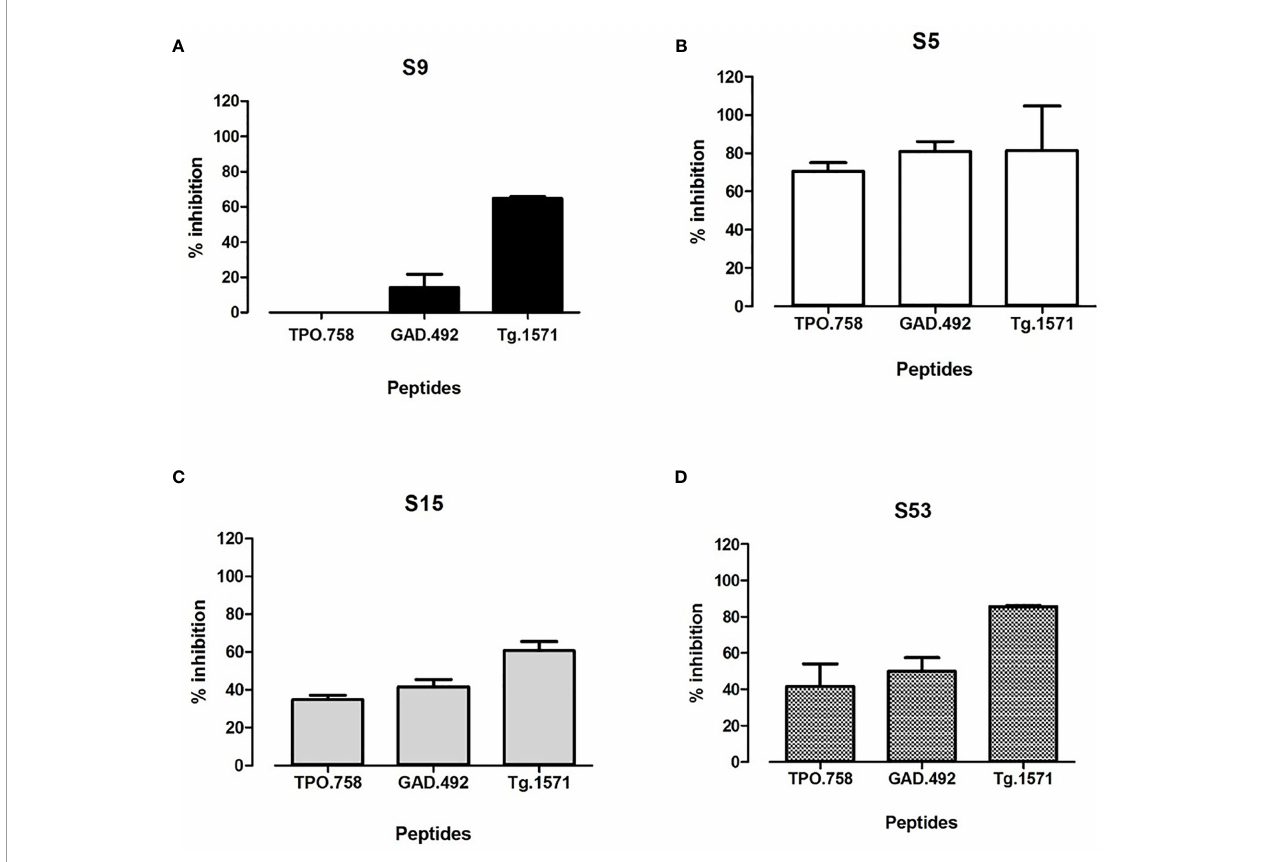
FIGURE 4 | The top 4 hit small molecules (S9, S5, S15, S53) were tested for blocking biotinylated TPO.758, GAD.492 and Tg.1571 binding to APS3v-HLA-DR3 in ELISA. Figure 4 shows the ELISA results of blocking TPO.758, GAD.492 and Tg.1571 binding APS3v-HLA-DR3 by S9 (A) , S5 (B) , S15 (C) and S53 (D)